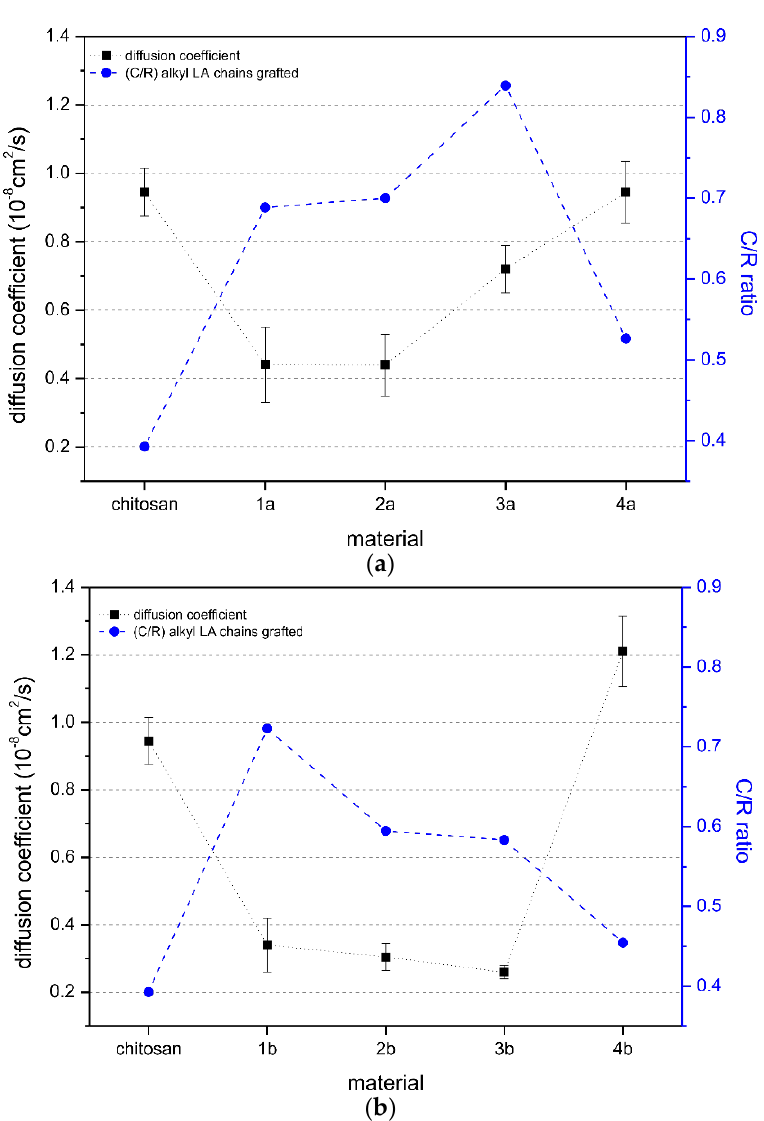
Figure 7. Diffusion coefficient vs. relative amount of grafted linoleic acid for ( a ) the EDC and ( b ) EDC/NHS coupling system.